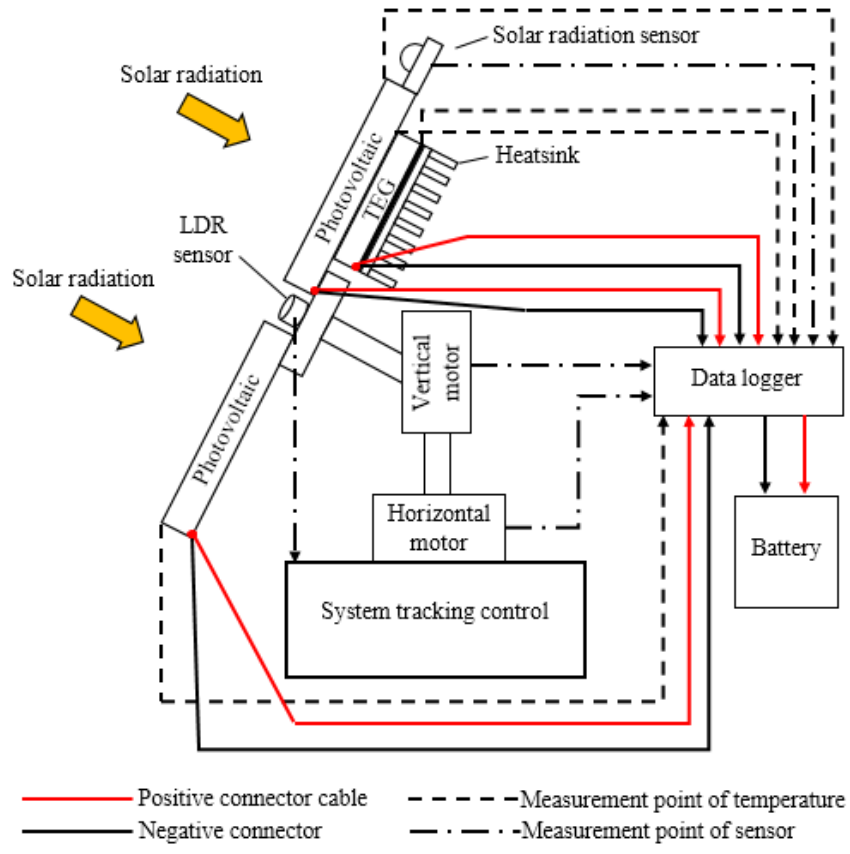
Figure 5 . The schematic diagram of the experimental data measurement . Figure 5. The schematic diagram of the experimental data